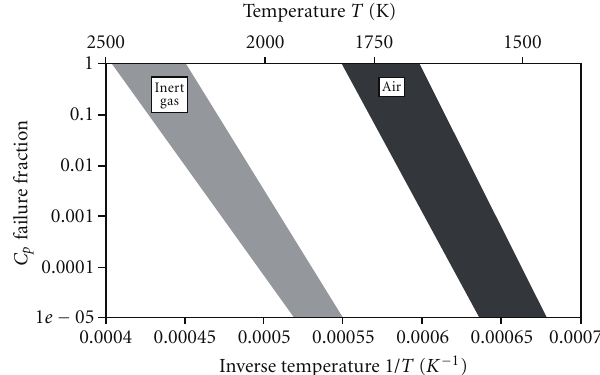
Figure 11: Comparison of SiC layer stability (failure fraction) in air and in an inert gas. The data range takes into account fuel burn-up and oxidation/heating